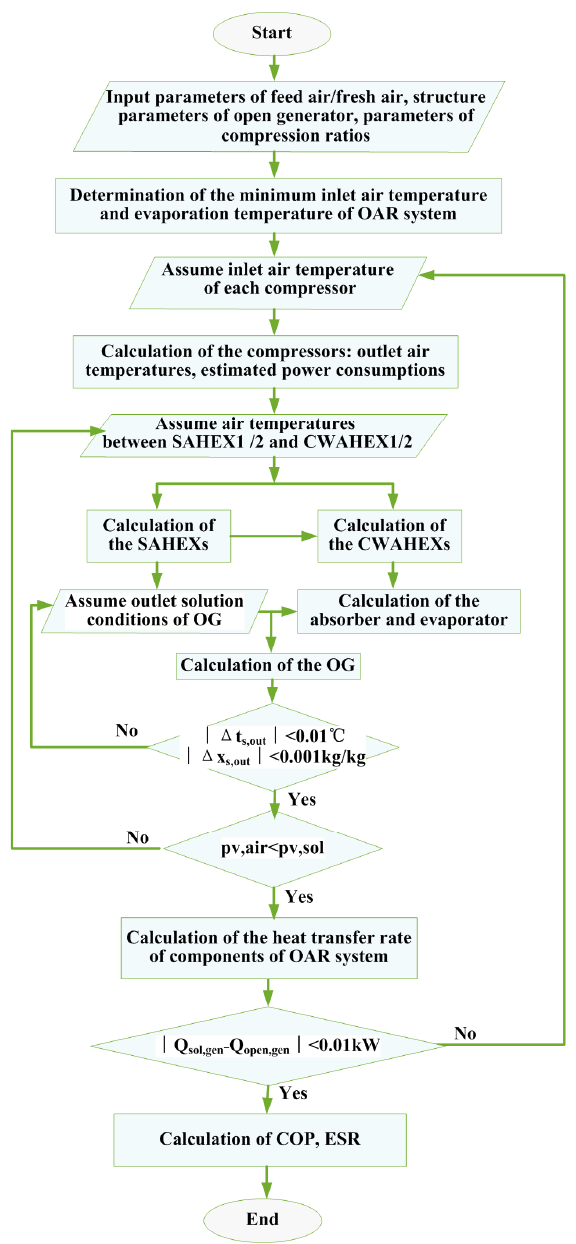
Figure 4. Calculation procedure of the model.